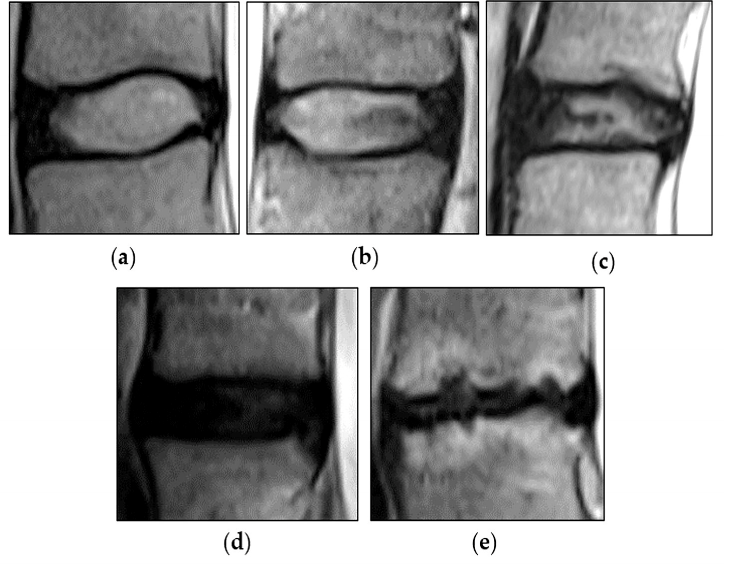
Figure 1. The Pfirrmann grading system: grade I ( a ), grade II ( b ), grade III ( c ), grade IV ( d ), and grade V ( e ).